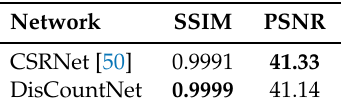
Table 3. Comparison of probability heat-map